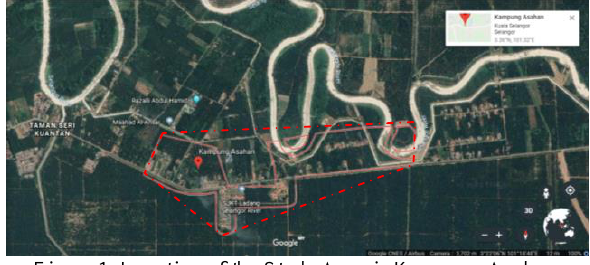
Figure 1. Location of the Study Area in Kampung Asahan, Kuala Selangor (see red polygon)